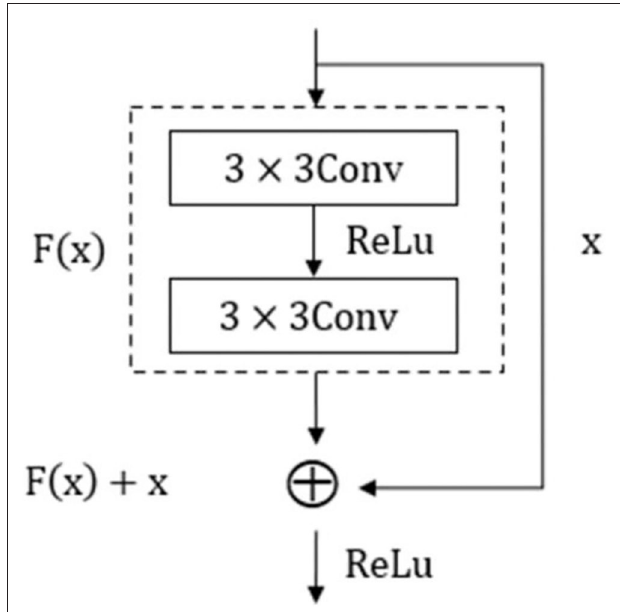
FIGURE 10 | Residual